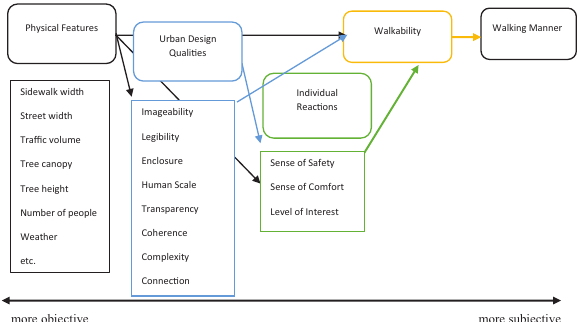
Figure 2. Walkability conceptual framework (source: Ewing et al., 2006, p. 225)